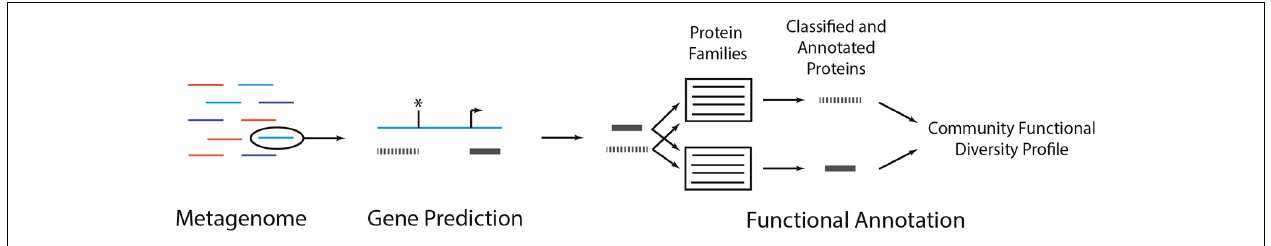
predictions. Each predicted protein can then be subject to functional annotation , wherein it is compared to a database of protein families. Predicted peptides that are classified as homologs of the family are annotated with the family’s function. Conducting this analysis across all reads results in a community functional diversity profile. As discussed in the main text, there are alternative annotation strategies and variations on this general